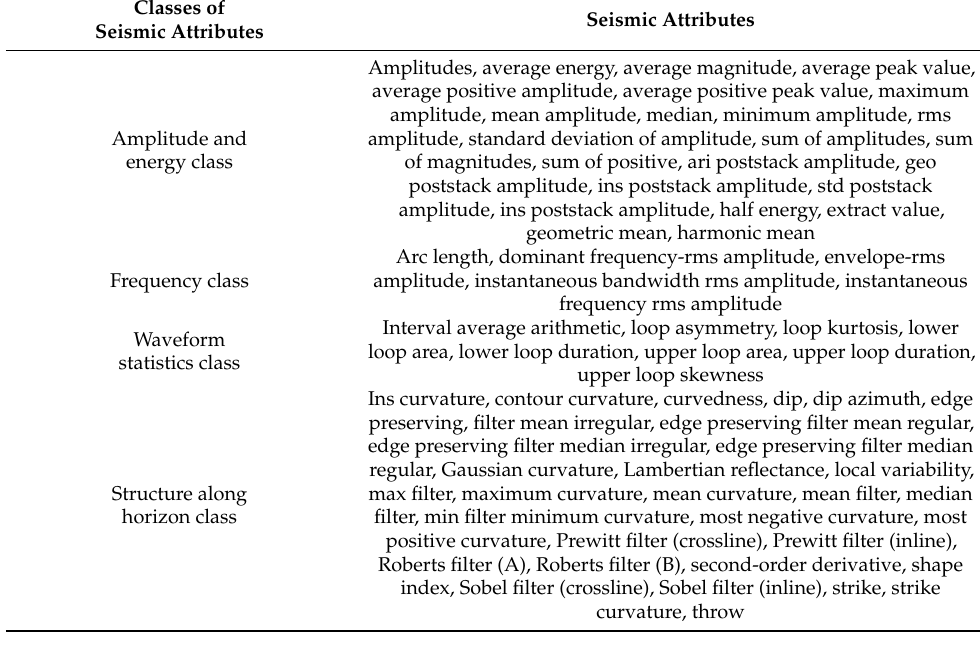
Table A2. Preliminary seismic attribute data corresponding to geological boreholes in the exploration stage (after normalization).